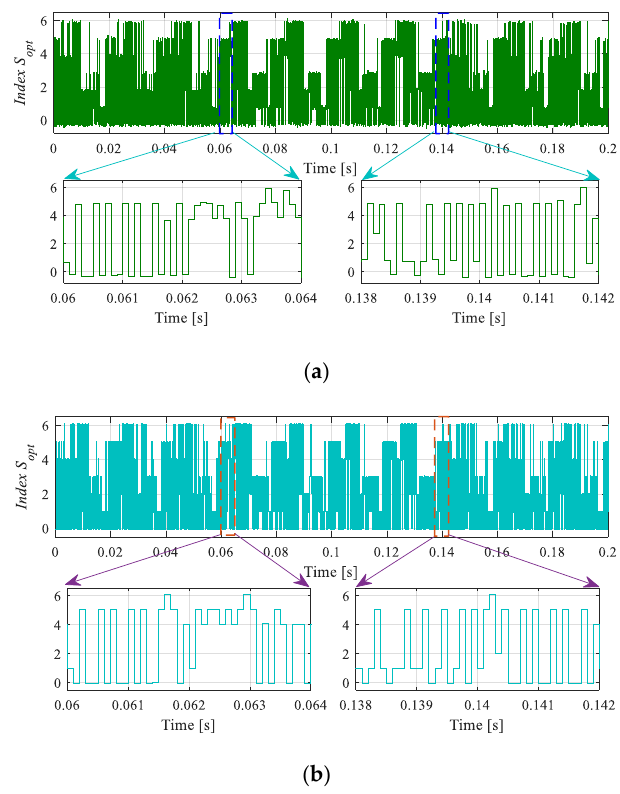
Figure 15. Experimental results: the index number of selected optimum switching state S opt in each sampling interval for the FS-MPC in ( a ) αβ -frame and ( b ) dq -frame.